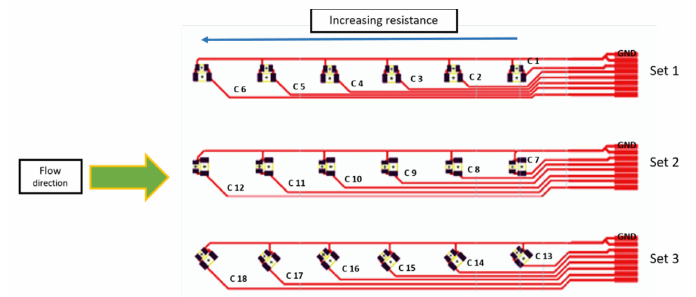
Figure 16. Labeling of components on the